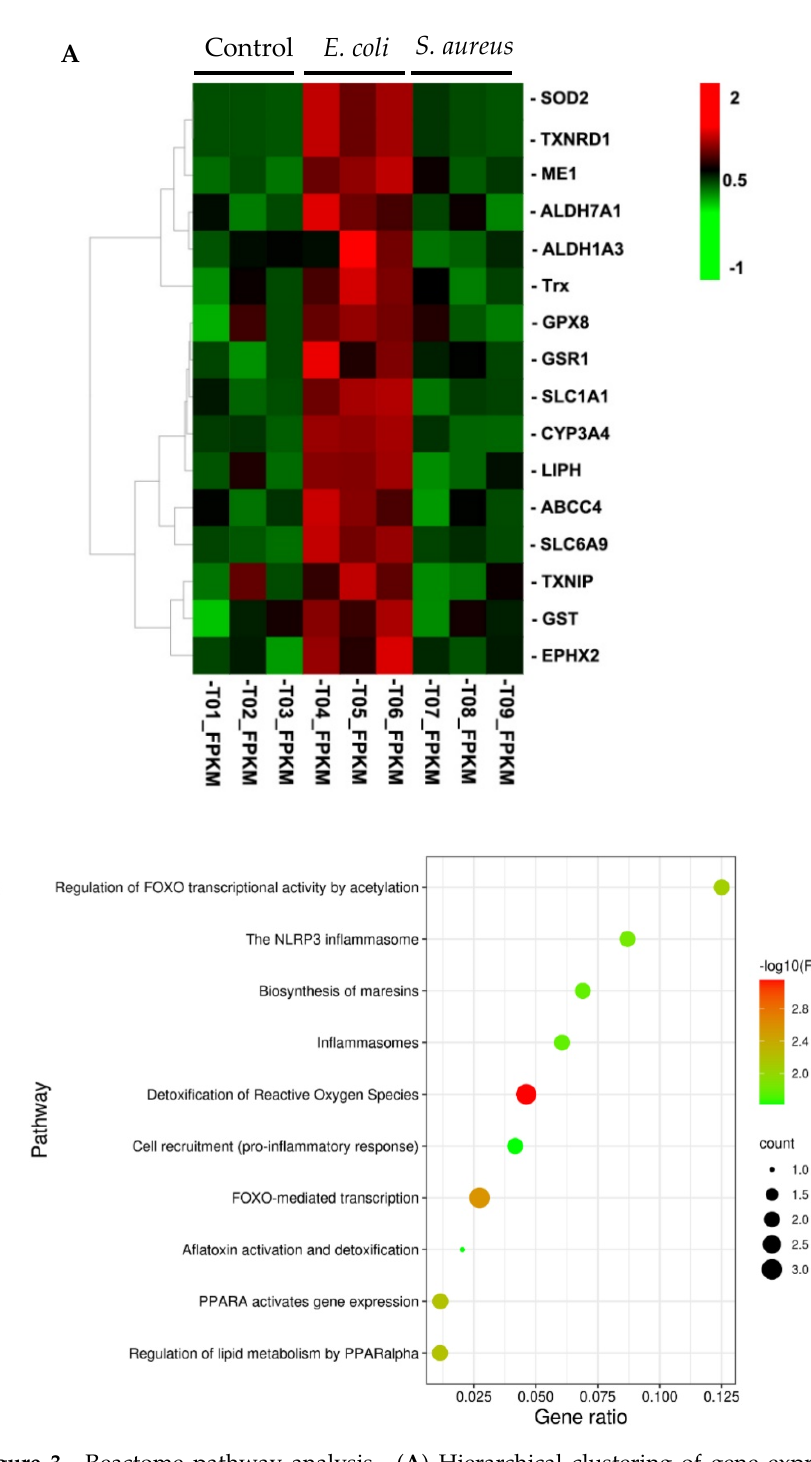
Figure 3. Reactome pathway analysis. ( A ) Hierarchical clustering of gene expression for the 16 selected Nrf2 target genes. Rows represent individual genes and columns represent the expression changes of replicate for each investigated group. Red color indicates relative over-expression, while green color indicates relative under-expression. ( B ) Bubble plots displaying over-represented Reactome pathways. y-axis, functional pathways; x-axis, the gene ratio of enriched relative to all genes in each pathway. The size of the bubble is proportional to the number of genes assigned to pathway and the color corresponds to the adjusted p value. A high FDR is represented by red, and a low value is represented by green.